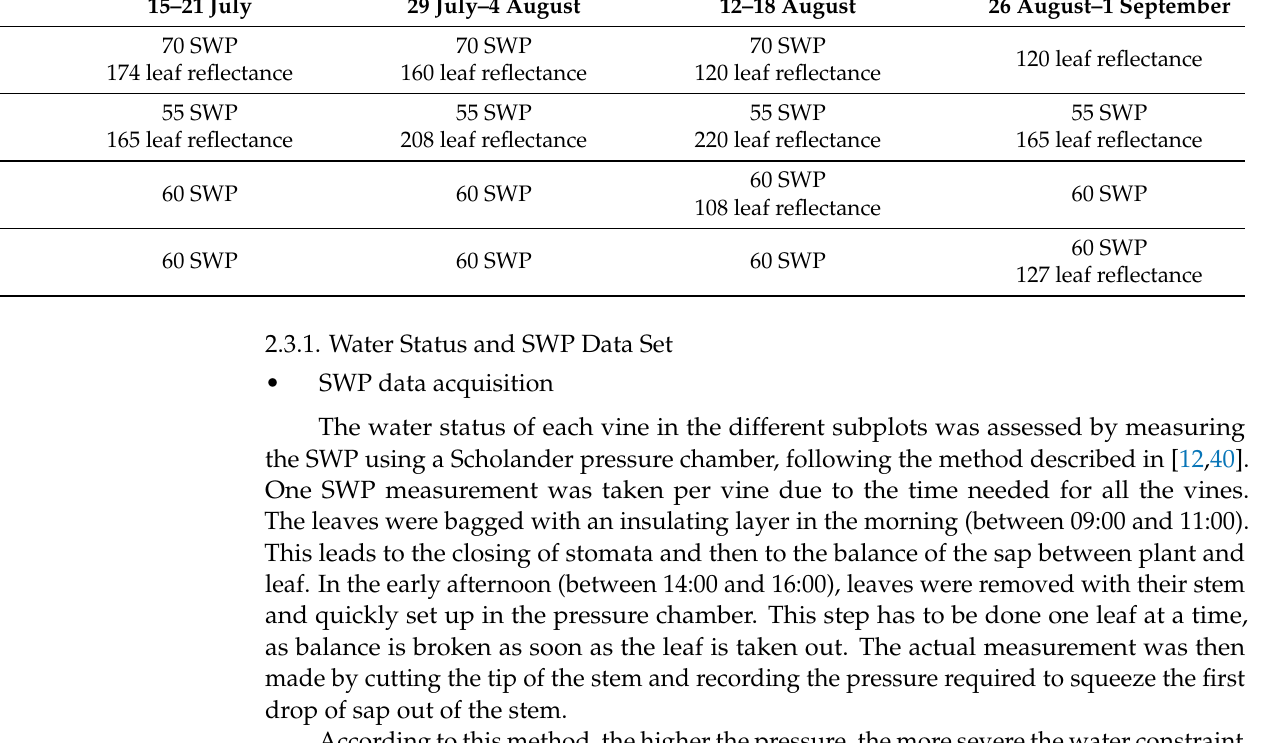
Table 3. Number of SWP and reflectance measurements acquired for each week and plot. Plots